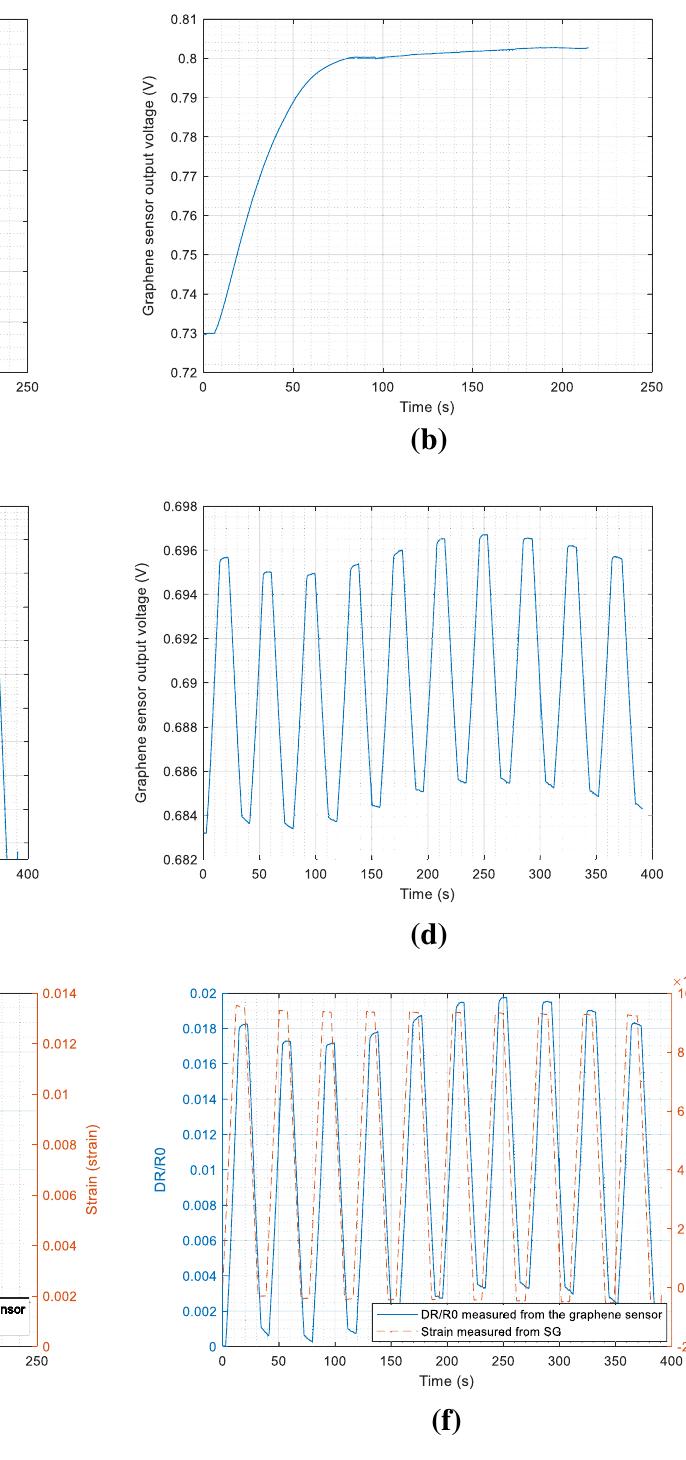
Fig. 9 Strain measurement obtained from strain gauge a and gra- phene sensor output voltage b for a normal tensile load applied to a CFRP sample and 10 cycles cyclic tensile load c and d respectively and resistance change comparison for the graphene-based